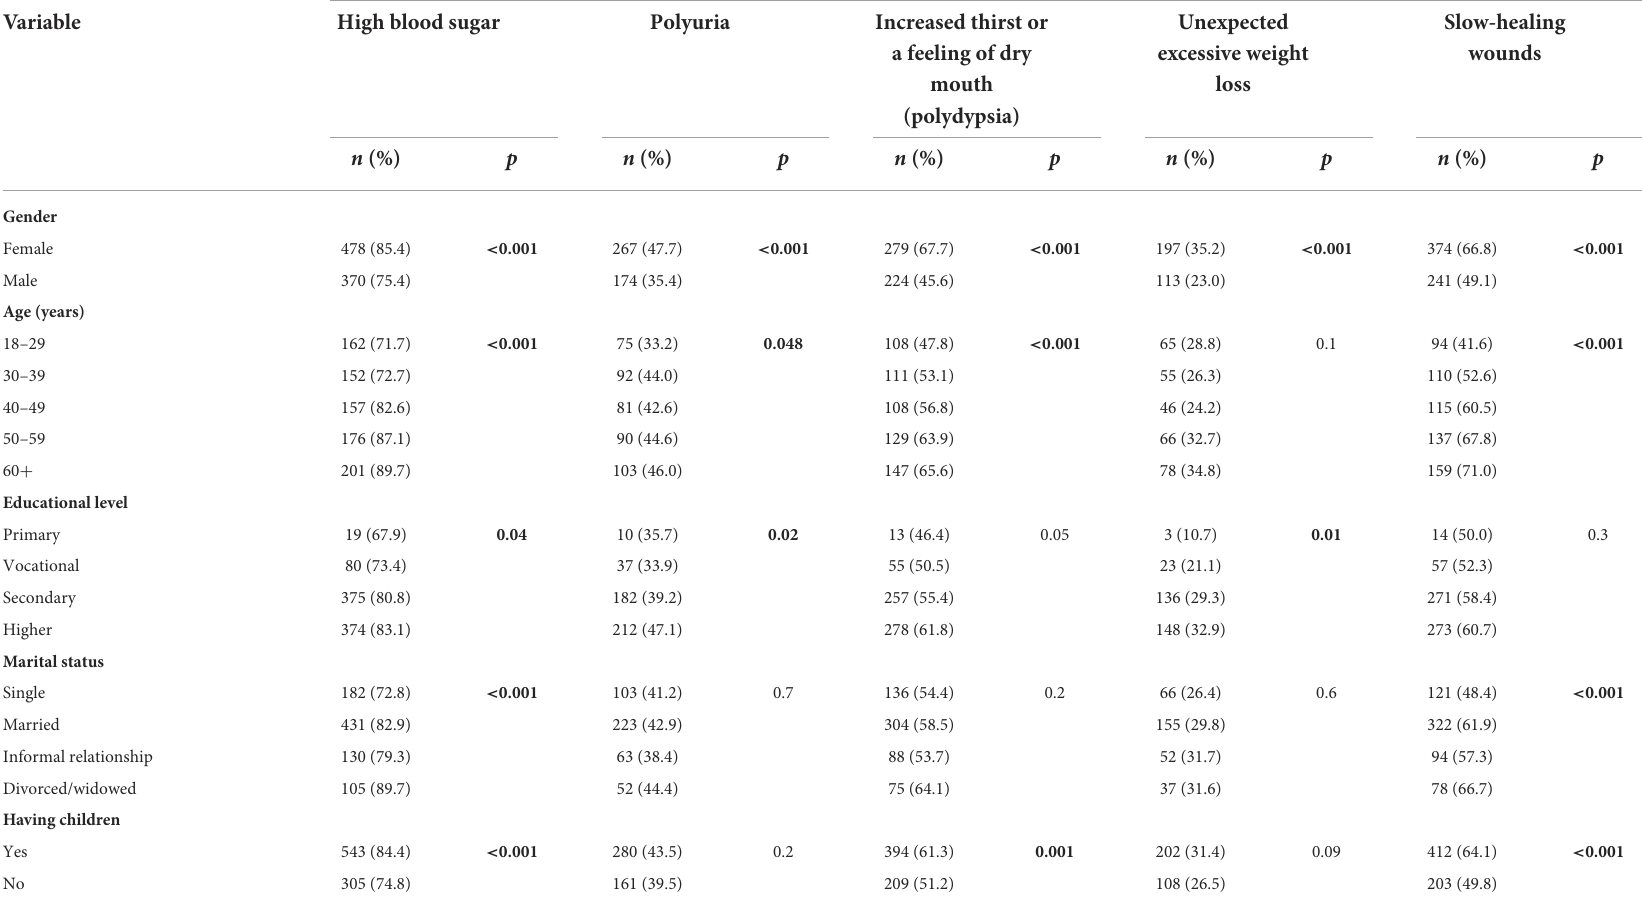
Diabetes symptoms - percentage of respondents who answered “yes” by sociodemographic factors